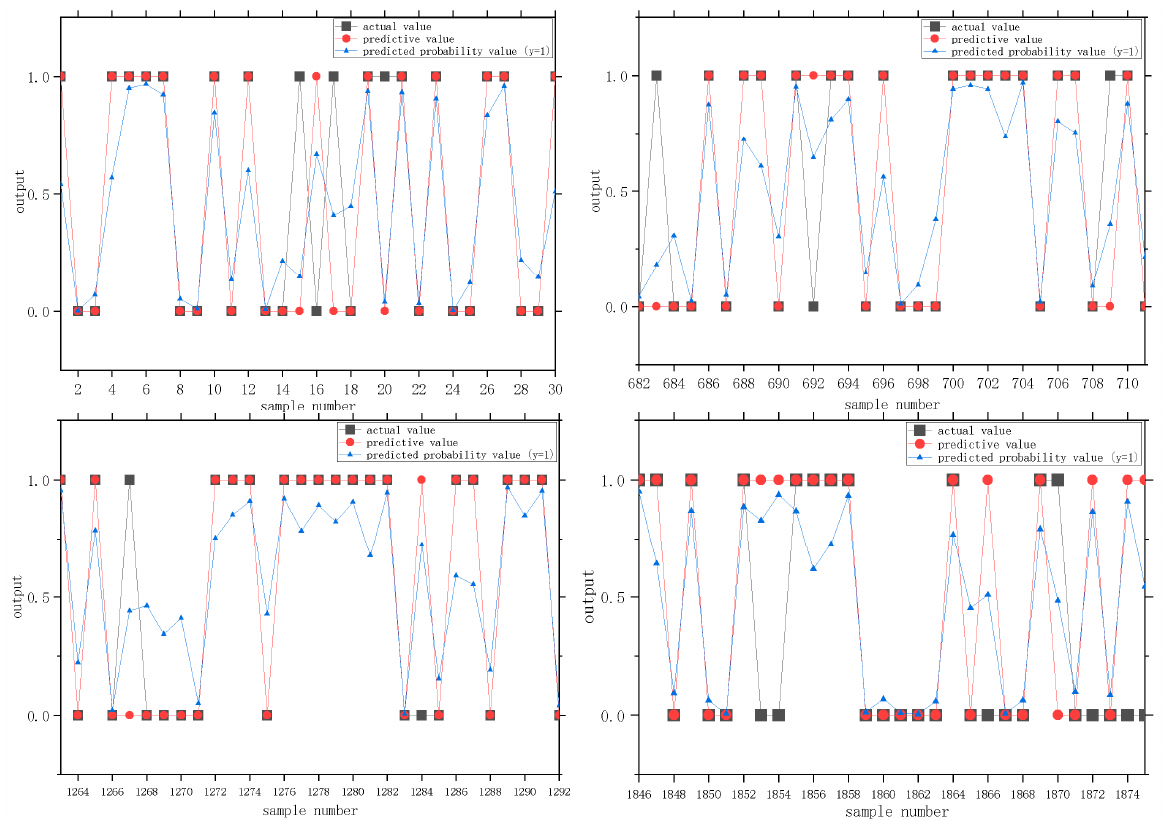
Figure 7. Comparison charts of the predictive and actual values of the SVM (part of the sample).